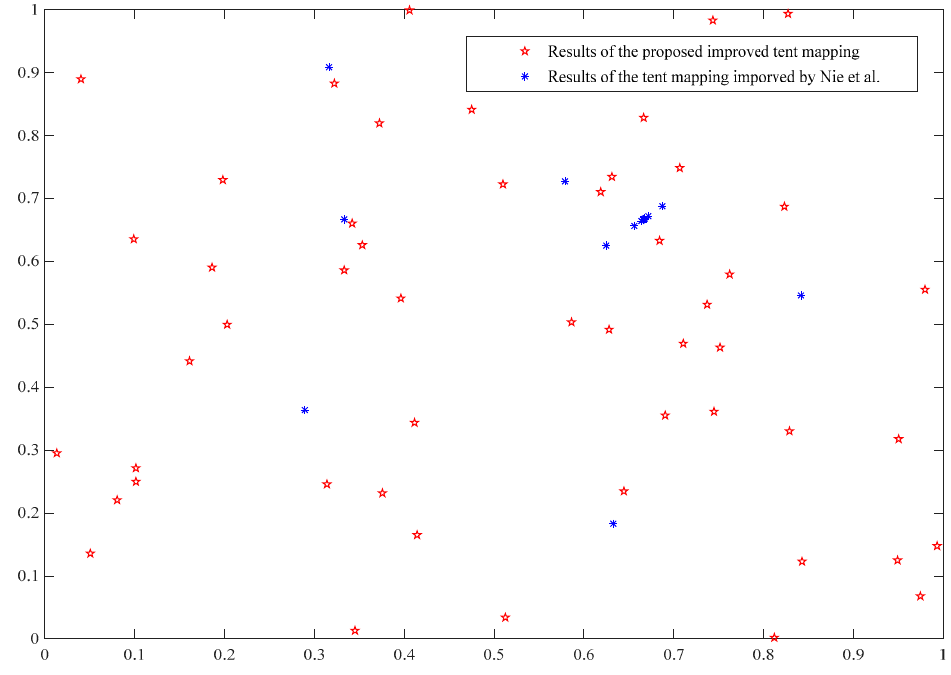
Figure 2. Comparison of data point distribution.